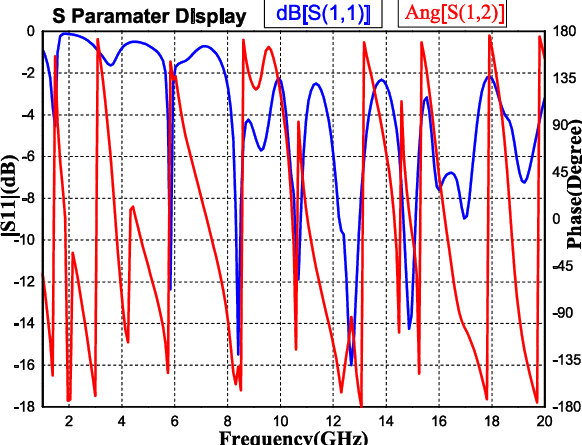
Figure 4: S 11 (dB) and S 12 (phase angle) of the SSHSS antenna Table 2 Summary of the simulated results Figure 6: Radiation pattern (a) elevation (b) azimuth Figure 7 shows the gain and directivity versus frequency plot. It is clear that proposed design shows high directivity at all resonance frequency while gain is moderate at first 3 resonance frequency. Figure 8 shows the VSWR plot (Voltage Standing Wave Ratio) of the proposed structure. For all frequency bands VSWR value is less than 2 which is within the acceptable limits for practical